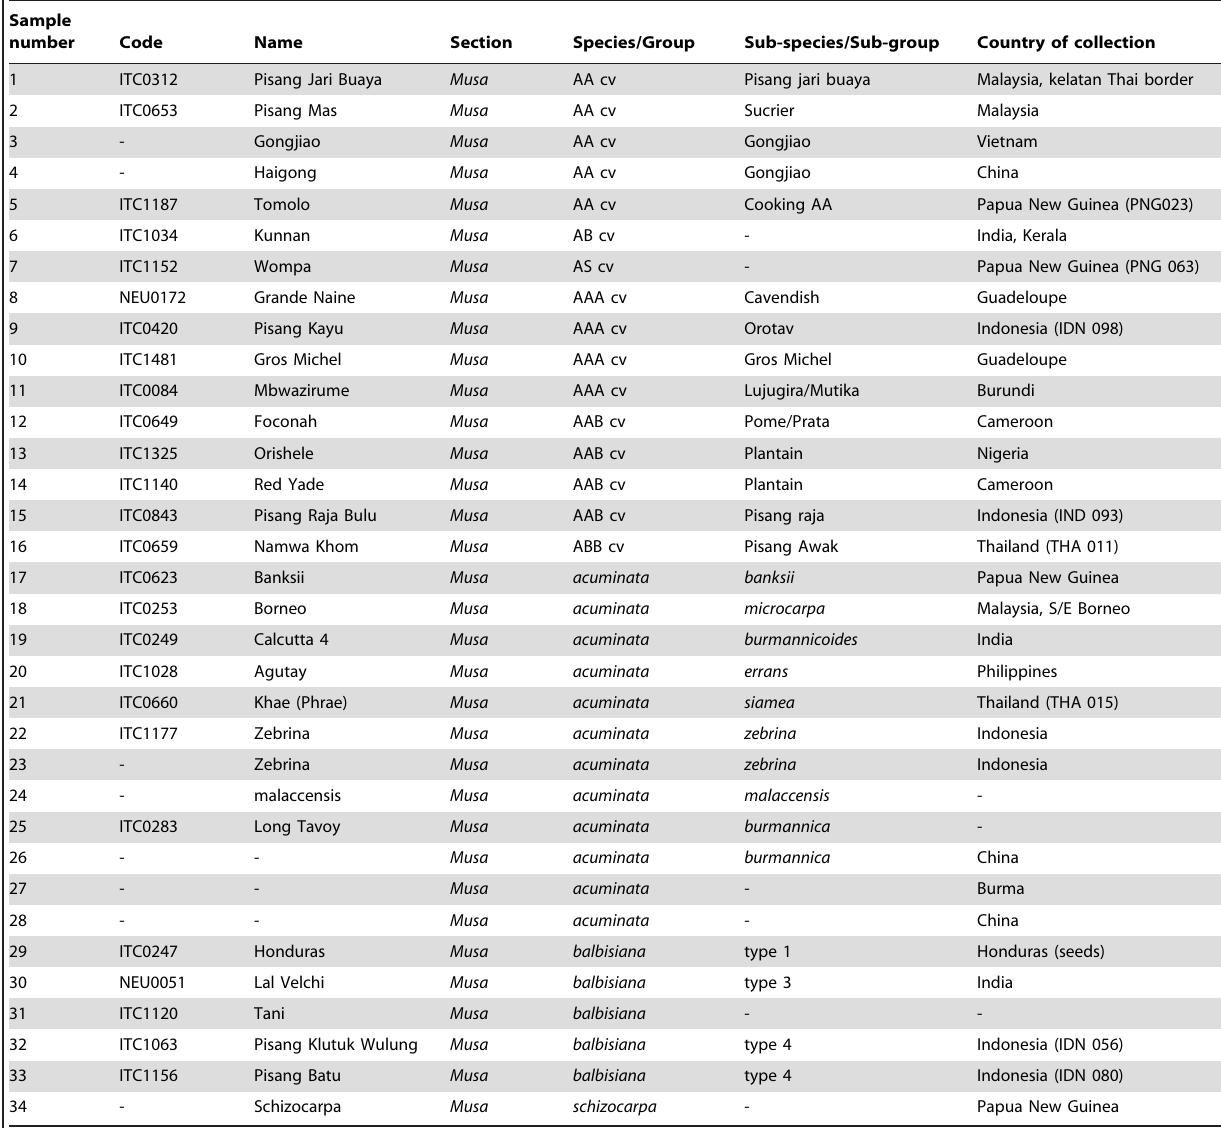
Table 1. Details of the Musa accessions used in this